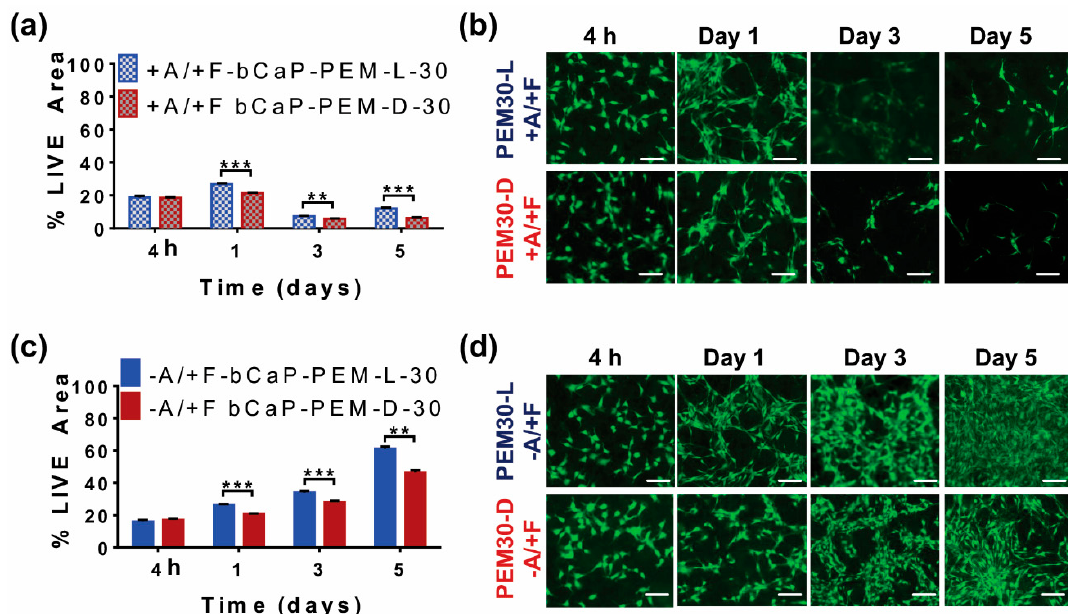
Figure A2. Effects of varying polyamino acid enantiomer type. ( a ) percent LIVE ® stained area of MC3T3-E1s cultured on AntiA-bCaP-PEM30-D-FGF2 (orange) as compared to cells cultured